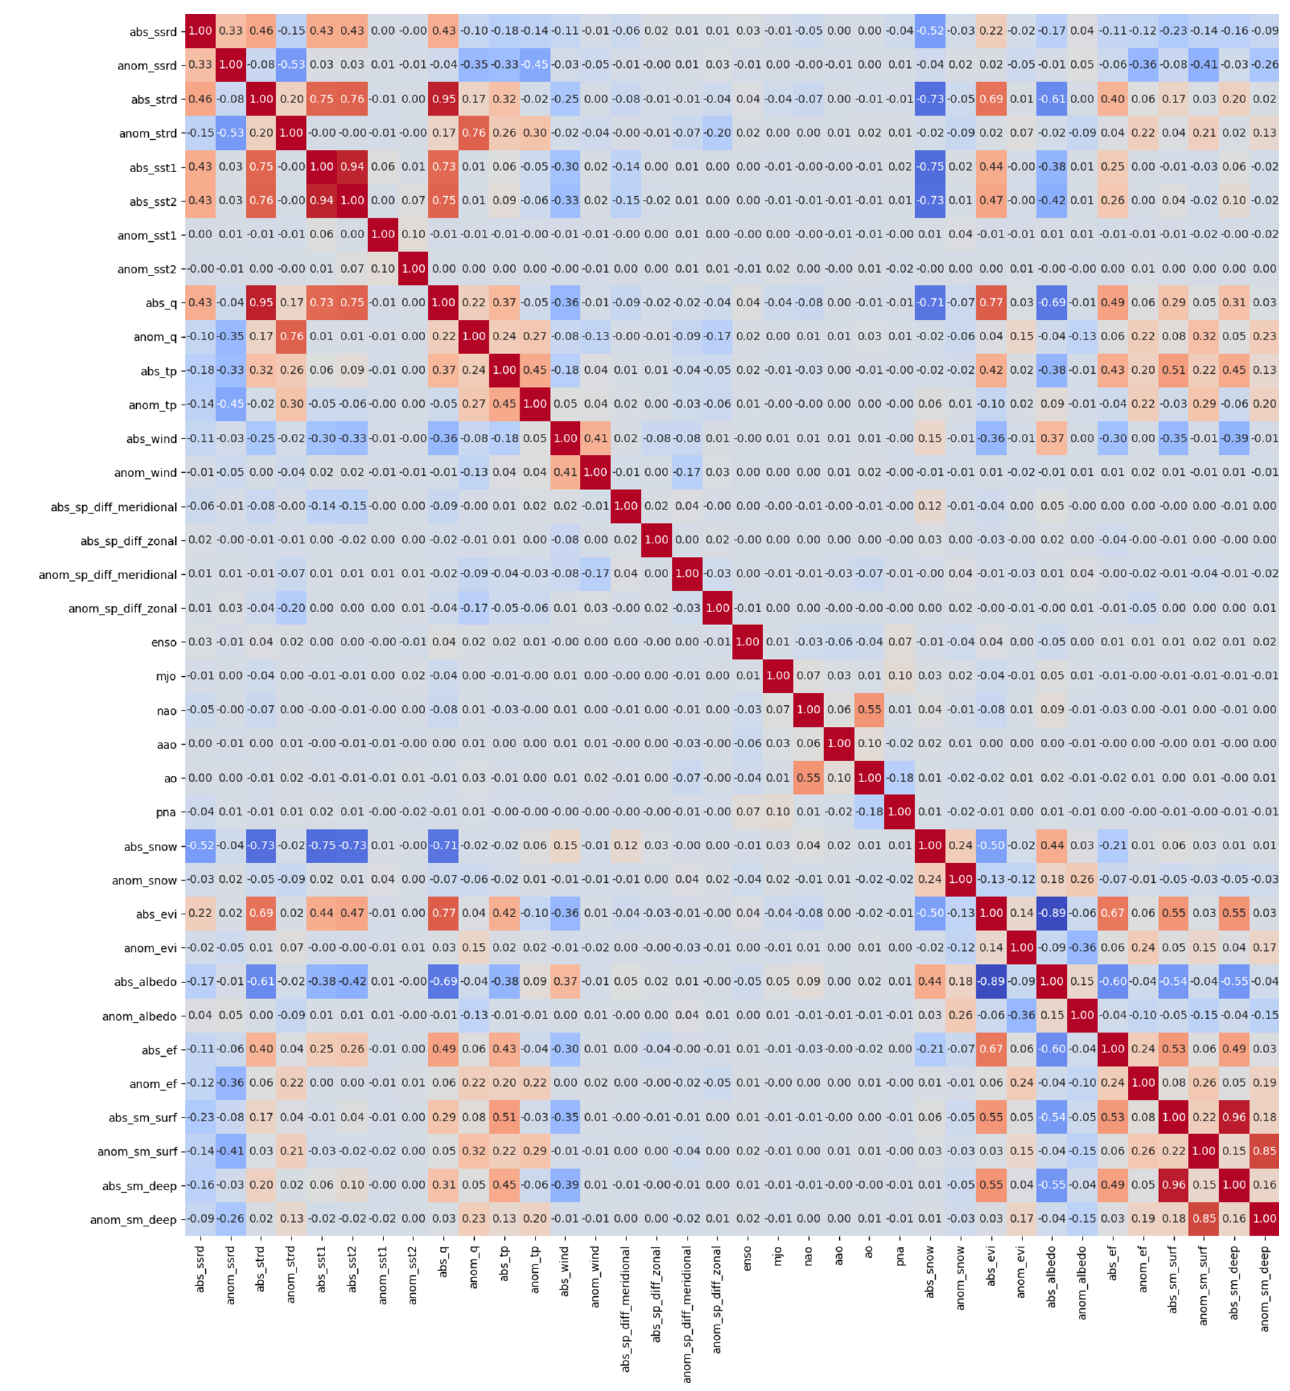
Figure A6. Spearman cross-correlation matrix among the 36 considered Earth system variables. A PDF version of this plot is provided in the